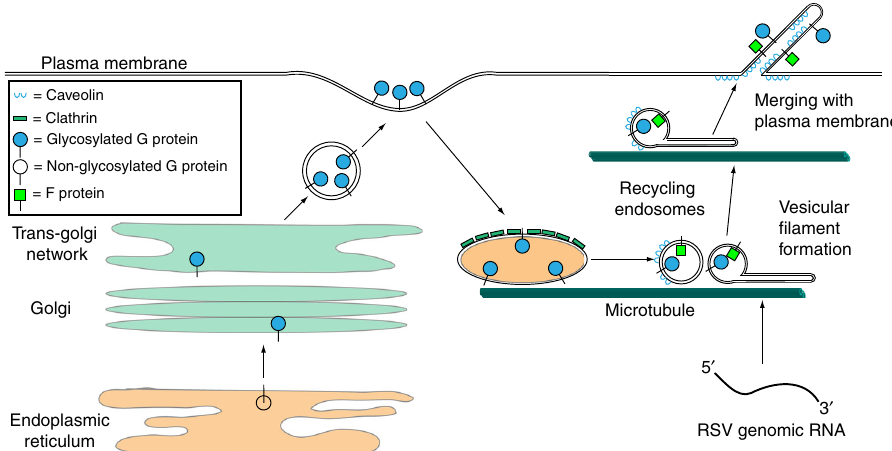
Fig. 10 Model of RSV fi lament formation prior to the plasma membrane via the rapid distension of vesicles along microtubules. Progeny RSV G is initially translated into the endoplasmic reticulum before being glycosylated and transported through the golgi network to the plasma membrane. RSV G, labeled with SBA, then is endocytosed and enters the recycling endosome compartment via clathrin-coated vesicles. These vesicles, which also contain RSV F, are distended by dynein along microtubules into fi lamentous particles prior to being loaded with RSV genomic RNA. During this recycling process, the vesicles colocalize with caveolin. The fi laments then mature by merging with the plasma membrane through an unknown